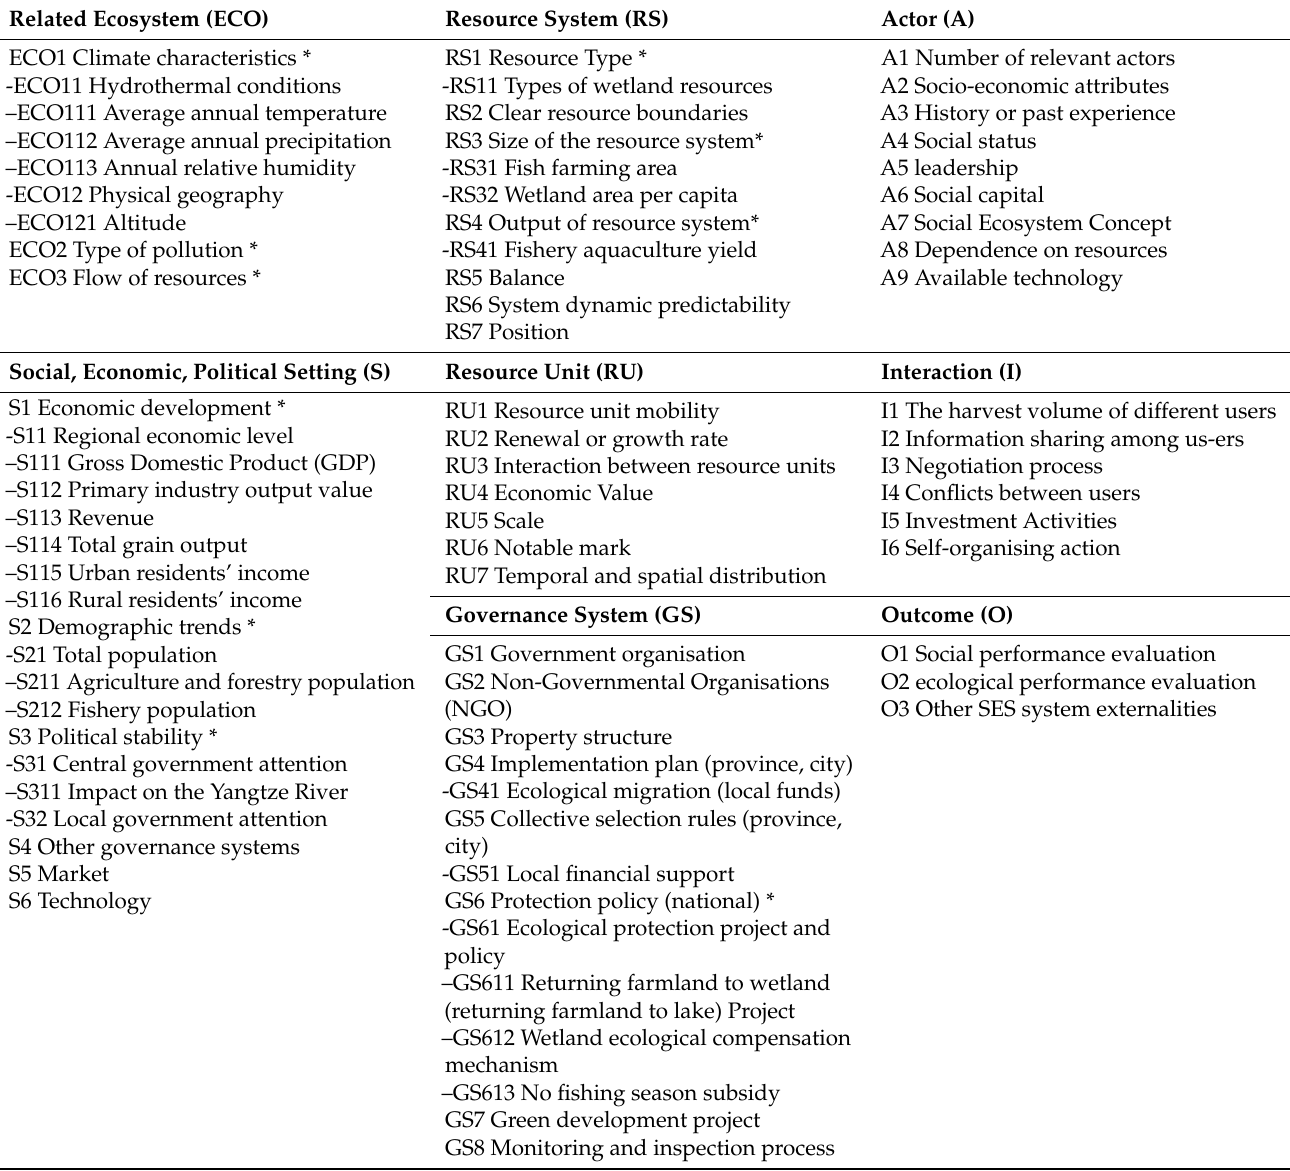
Table 1. Analysis variable table of organic integration between ecological environment protection and green development in Poyang Lake